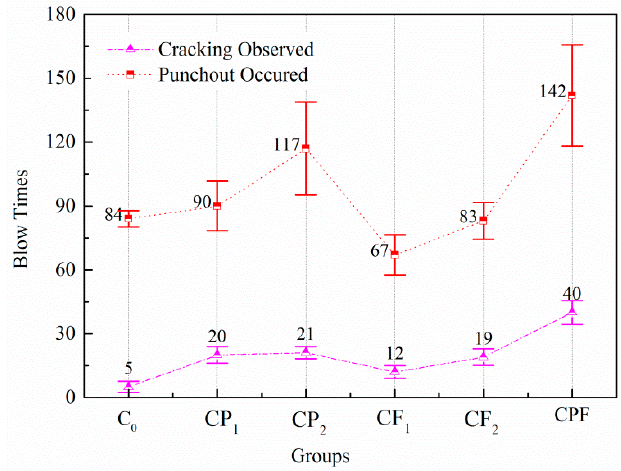
Figure 19. Impact test results of the same size (150 ×150 ×100 mm).